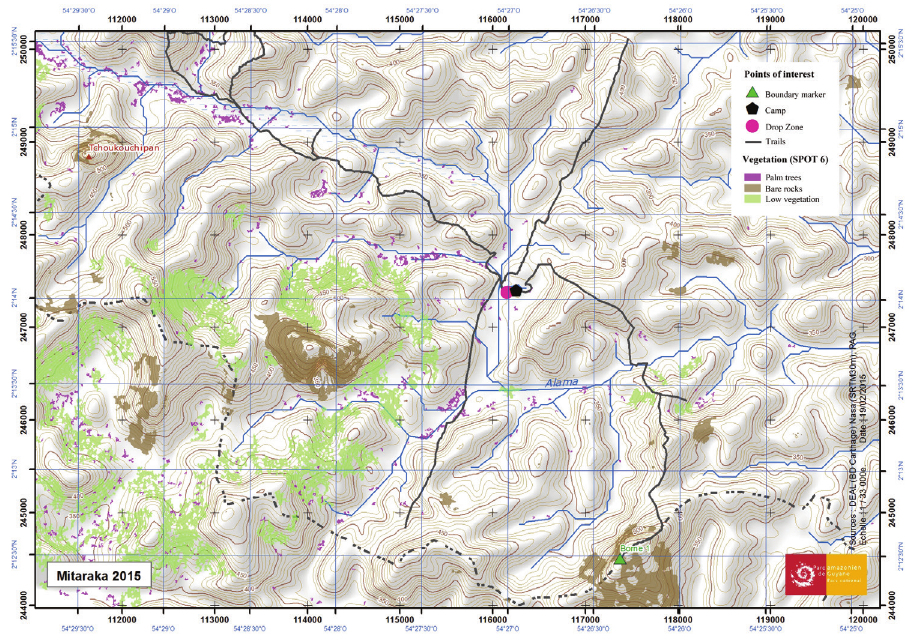
Figure 6. Mitaraka site map with four trails indicated (map by Maël